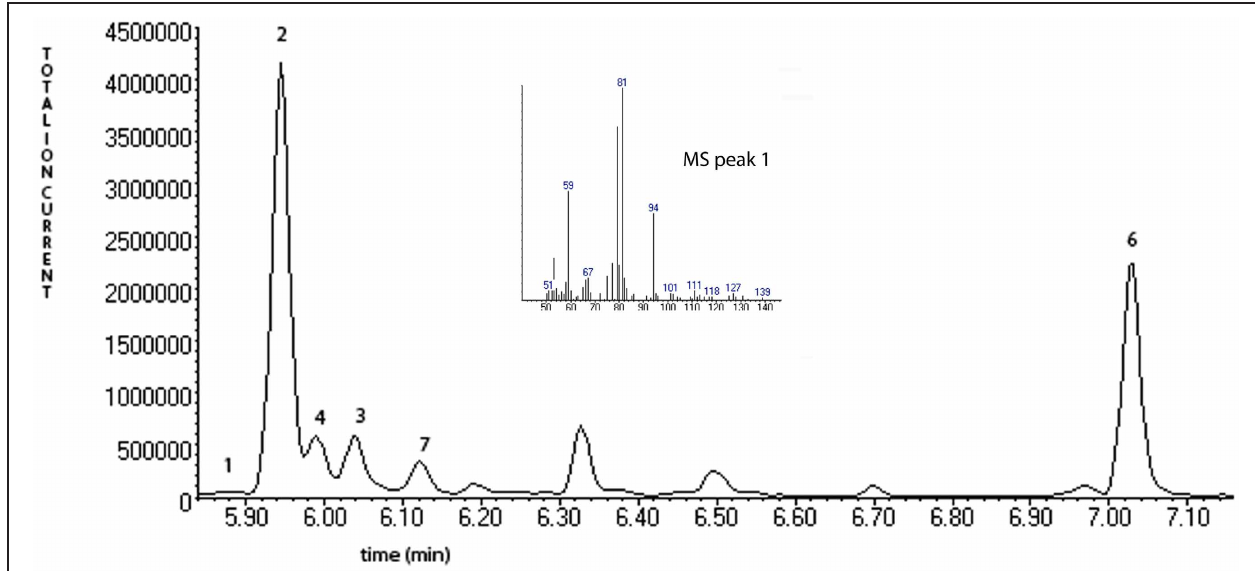
FIGURE 6 | A chromatogram of norcarane hydroxylation products, as generated by strain EPR92. Products are identified in Figure 3 . The inset shows the fragmentation pattern for peak 3, characteristic of the ring-opened radical product ( 1 in Figure 3 ).